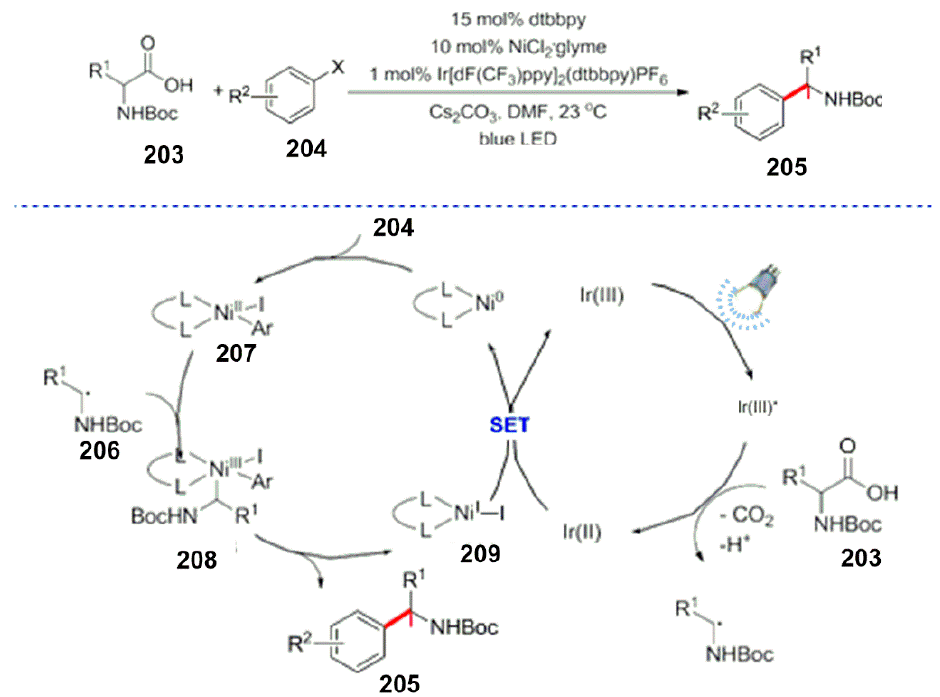
Scheme 54. Photocatalysis and metal Au catalyzed cyclization.